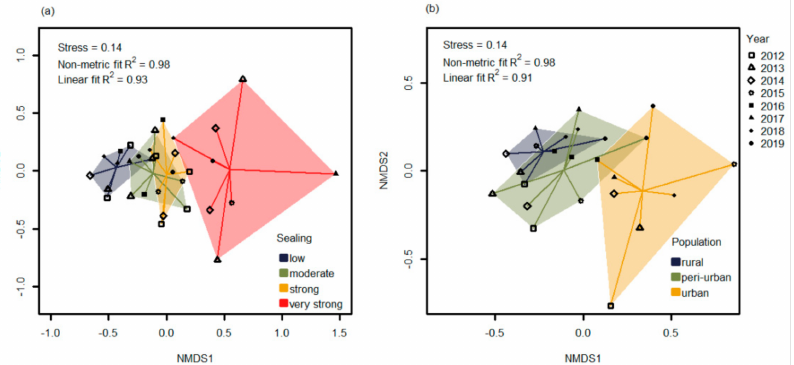
Figure 2. Non-metric multidimensional scaling (NMDS) showing differences in mosquito species communities of different levels of urbanization assessed by ( a ) soil sealing and ( b ) human population density , using years as replicates